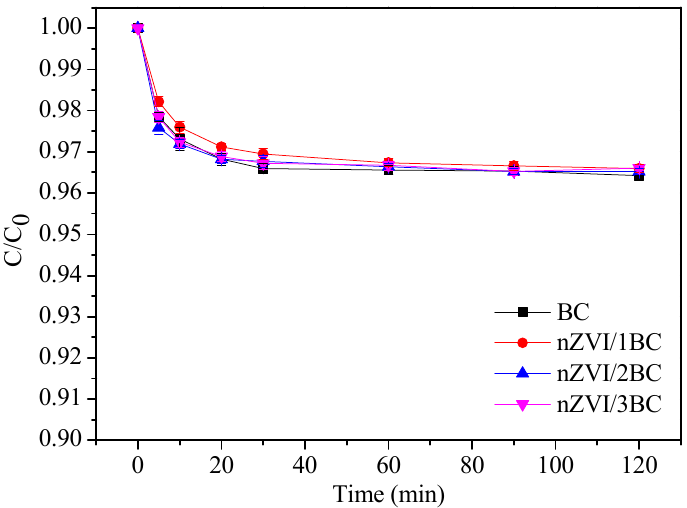
Figure 5. The adsorption of diatrizoate (DTZ) by BC, nZVI/1BC (mass ratio of 1:1), nZVI/2BC (mass ratio of 1:2), and nZVI/3BC (mass ratio of 1:3).